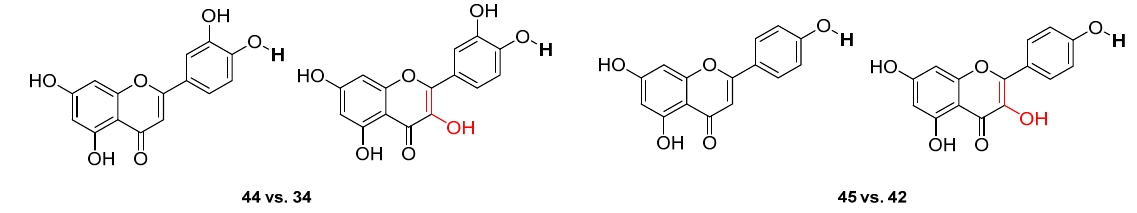
Figure 9. Comparison between flavones ( 44 and 45 ) and flavonols ( 34 and 42 )